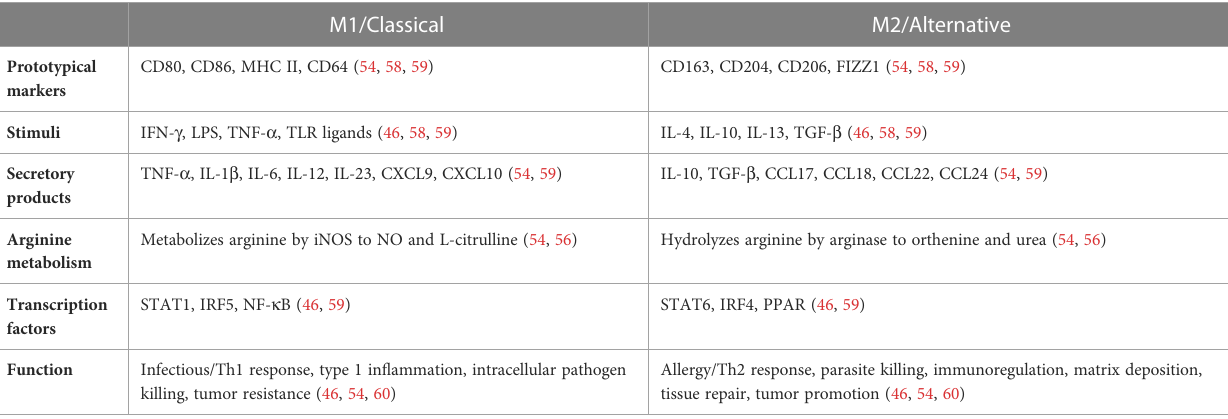
TABLE 1 Two extremes of a spectrum of human macrophage